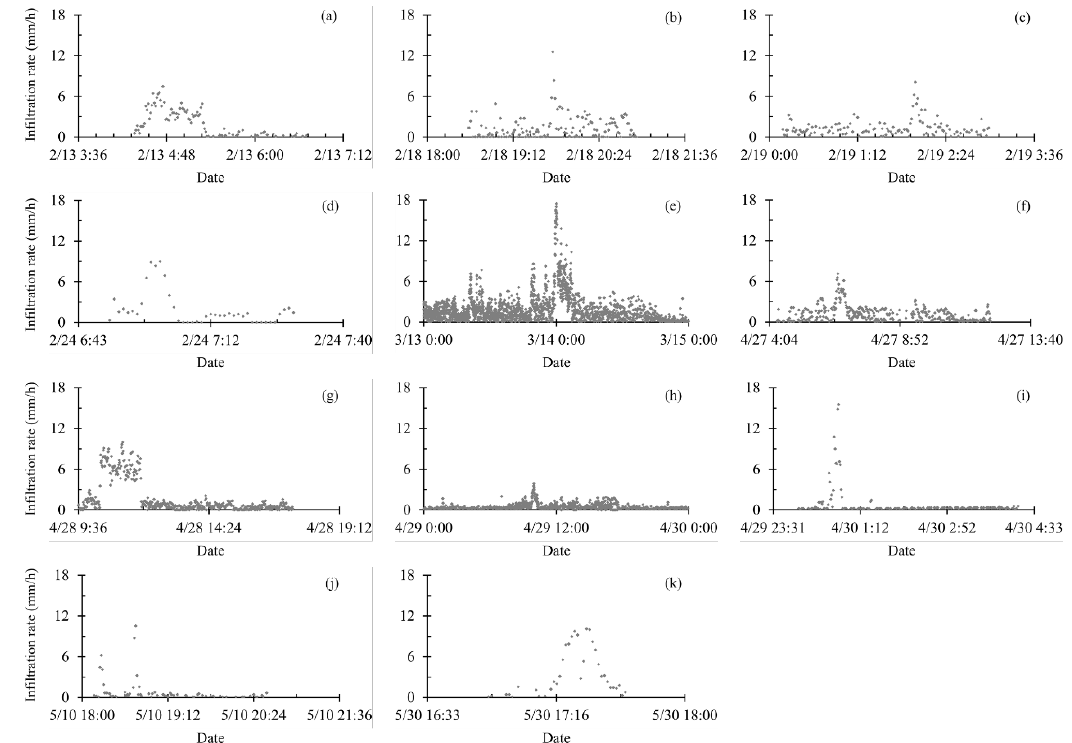
10 of 15 Table 3. Comparison of field water content value obtained in the soil with literature values. 𝜽 𝑭𝑪 , cm 3 /cm 3